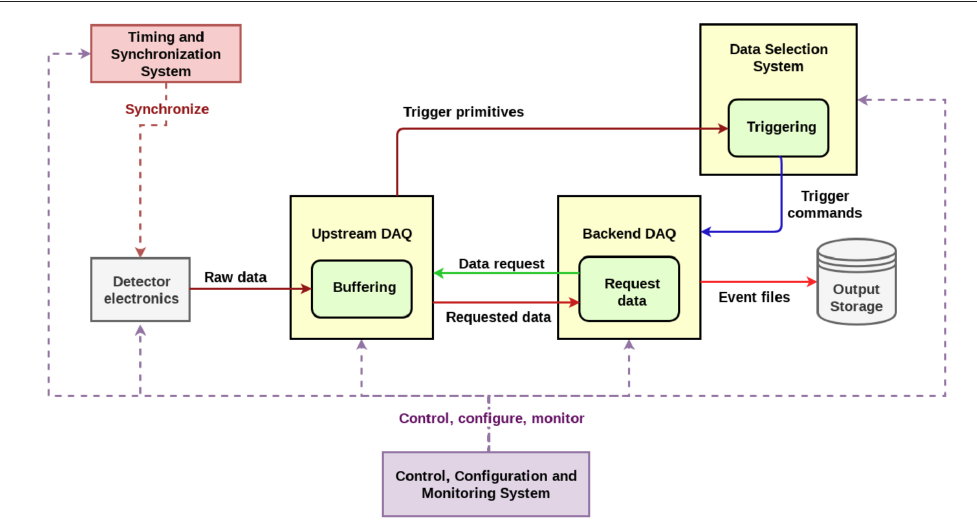
Figure 2. Overview of the DUNE DAQ system, highlighting the main di ff erences from its prototype. The DUNE DAQ does not have a central trigger, but it is completely data driven and relies on the self-triggering approach.